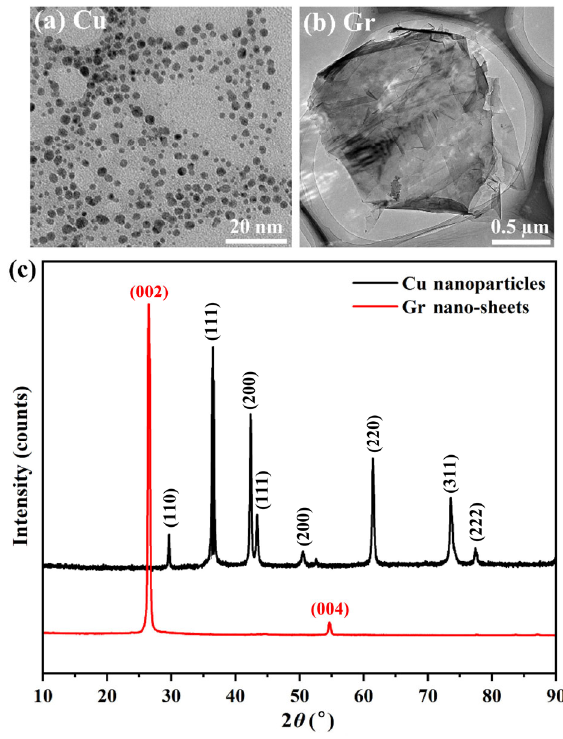
Fig. 2 Characterization and morphology of the Cu and Gr nanomaterials: (a, b) TEM images and (c) XRD patterns.